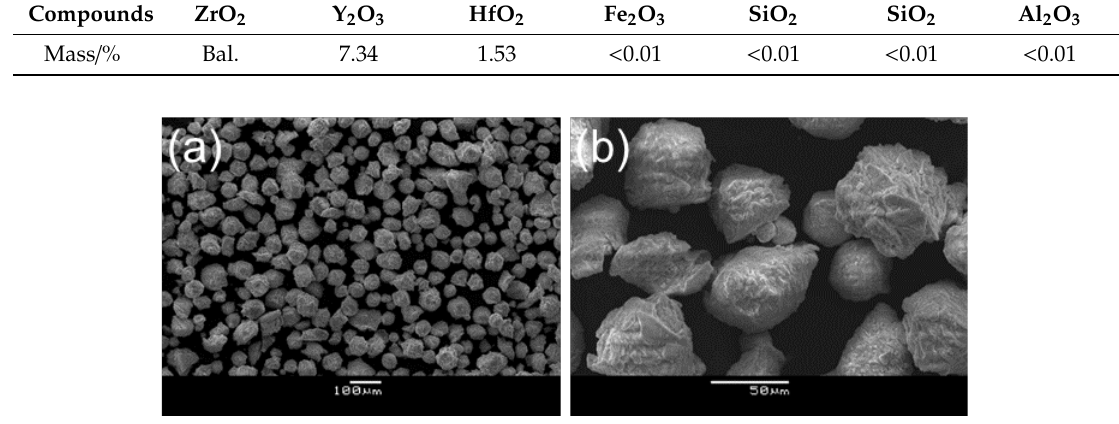
Figure 2. Morphology of YSZ powder: ( a ) 100×; ( b ) 500×.